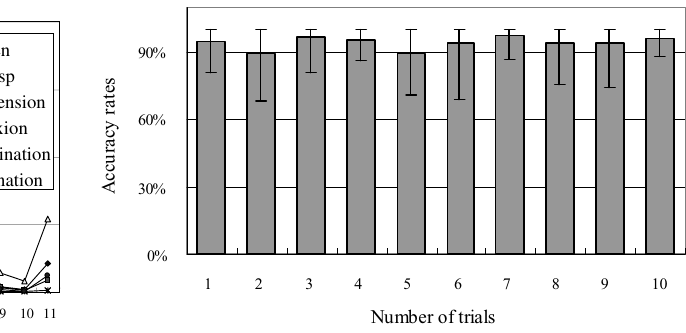
Figure 6 Feature vectors of two channels of